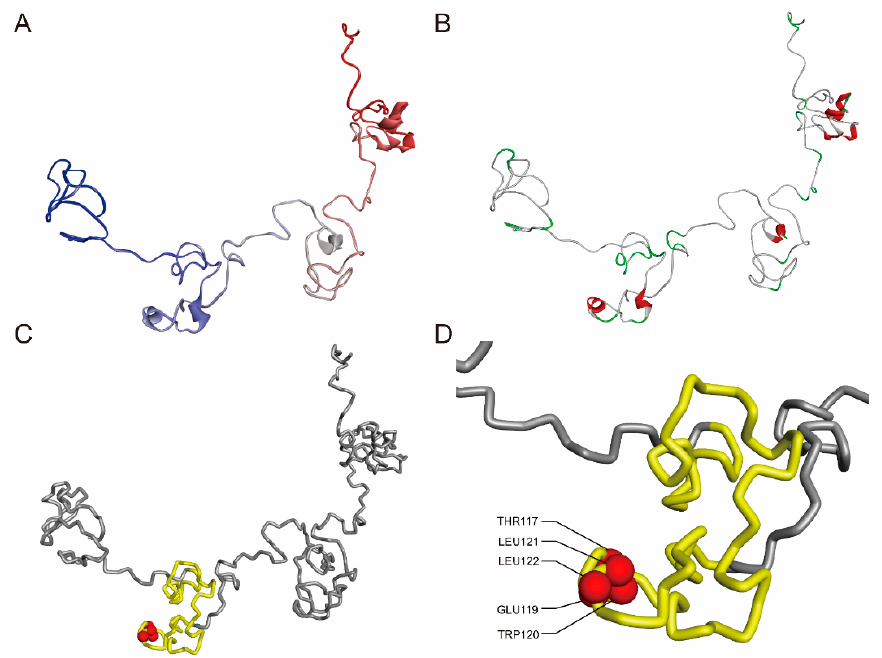
Figure 1. Three-dimensional protein model of FmTCP15 protein. ( A ) FmTCP15 3D structure displayed in solid ribbon style. N-to-C terminals: color residues in a continuous gradient from blue at the N-terminus through white to red at the C-terminus. ( B ) FmTCP15 3D structure displayed in solid ribbon style, secondary type: colors according to secondary structure. Helices are red, turns are green, and coils are white. ( C ) FmTCP15 3D structure displayed in tube style: the TCP domain is yellow, and the five predicted ligand binding sites (THR117, GLU119, TRP120, LEU121, and LEU122) are red balls. ( D ) The zoom-in view of the TCP domain of FmTCP15.